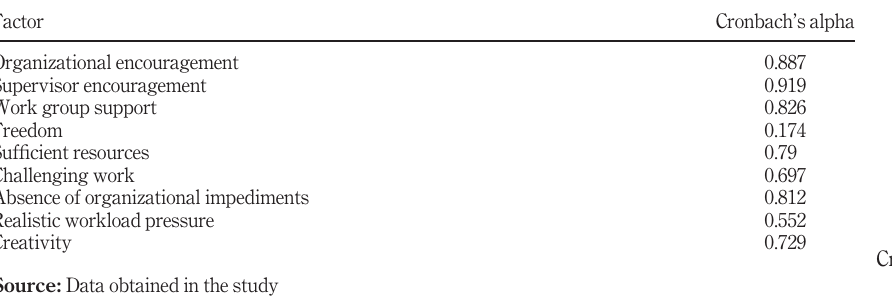
Table II. Cronbach ’ s alphas